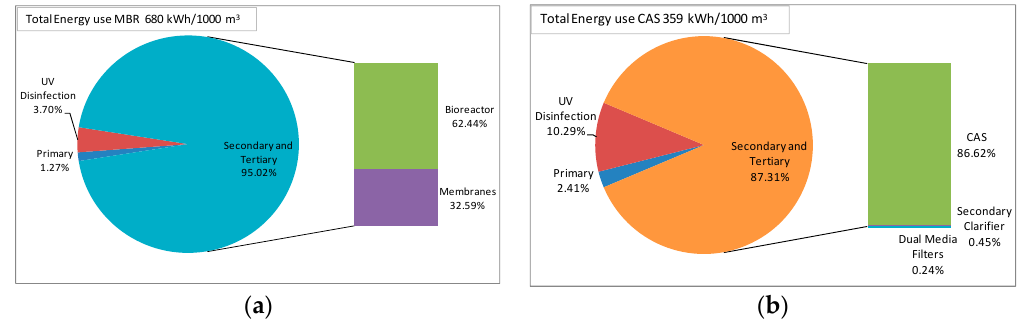
Figure 2. Percentage share of Energy Consumption for Primary, Secondary and Tertiary, and UV disinfection Unit Processes: ( a ) membrane bioreactor (MBR); ( b ) conventional activated sludge (CAS).